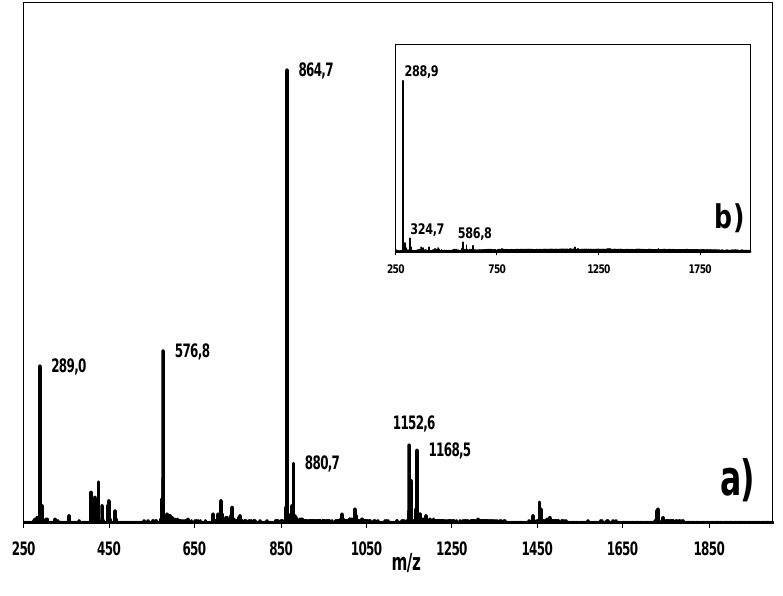
Figure 6. MS spectra (averaged over the retention time frame of the flavan-3-ols, 20-35 min) of a) the raw cocoa bean extract and b) the isolated and purified flavan-3-ols from this extract. The signals in the extract spectrum correspond to procyanidins. The small signals in the isolated flavanols correspond to ionization-induced adducts and fragments and background